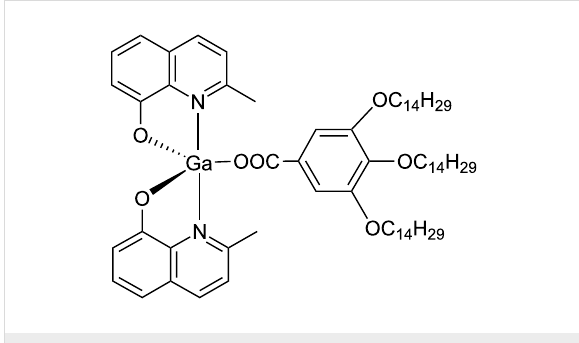
quinolinate groups responsible for intermolecular interactions in the crystalline organization grafted around the gallium(III) centre [61]. In this way a unconventional jellyfish shape molecule has been obtained and its molecular structure has been confirmed through single crystal X-ray diffraction (Figure 6). Despite its unusual molecular shape, this complex shows ther- motropic mesomorphism, with a lamello-columnar organiza- tion and, at the same time, a light-green emission with the typical high quantum yield of pentacordinated Ga(III) complexes (40% in solution) [62], has been